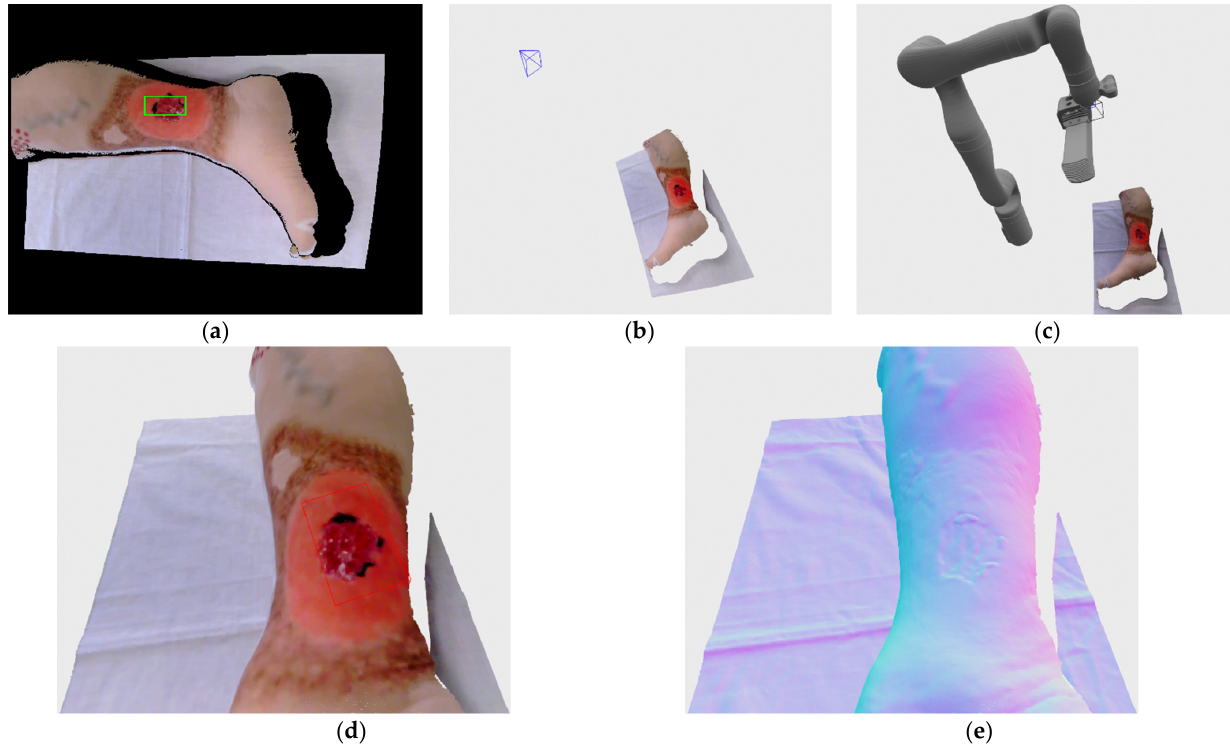
Figure 15. Recording of venous ulcer medical wound model: ( a ) wound detection at initial recording position; ( b ) recording pose relative to the recorded wound; ( c ) robot position in relation to the recorded wound in first and only recording; ( d ) final reconstructed 3D model; ( e ) final reconstructed 3D model with normal map rendering.